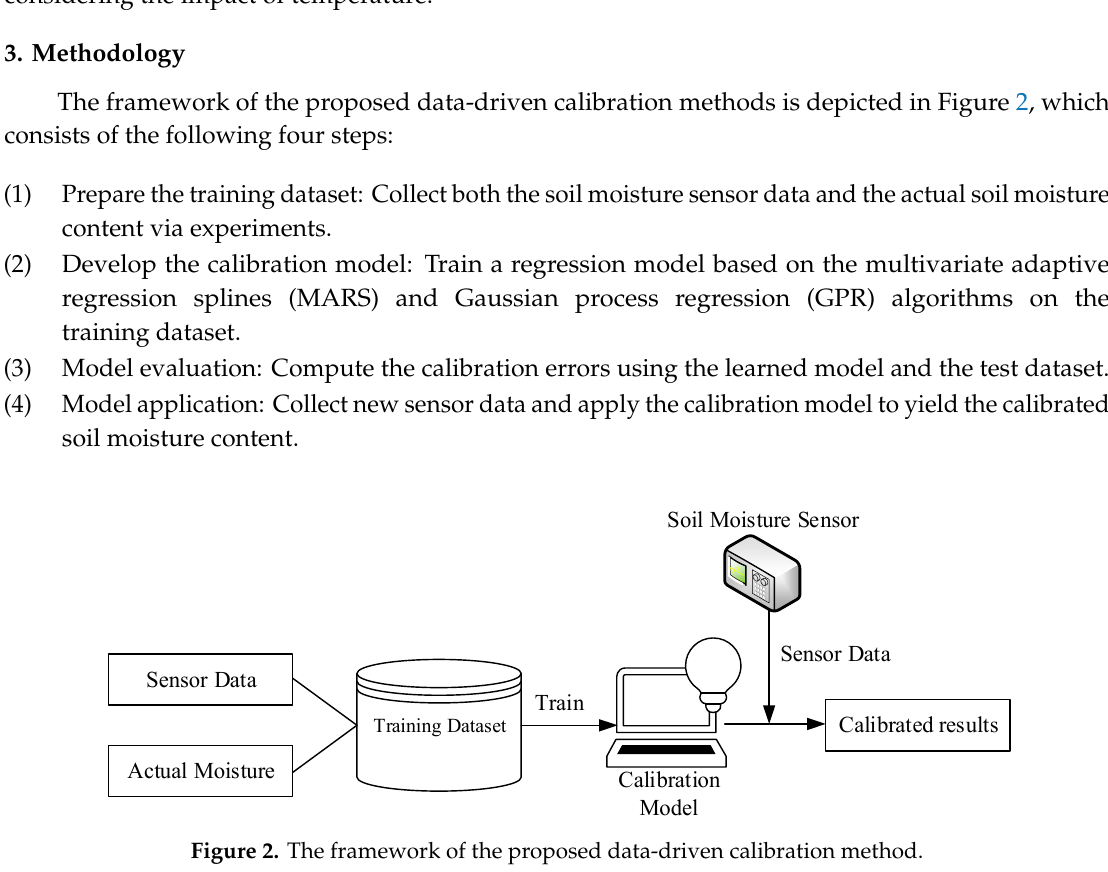
Figure 2. The framework of the proposed data-driven calibration method.